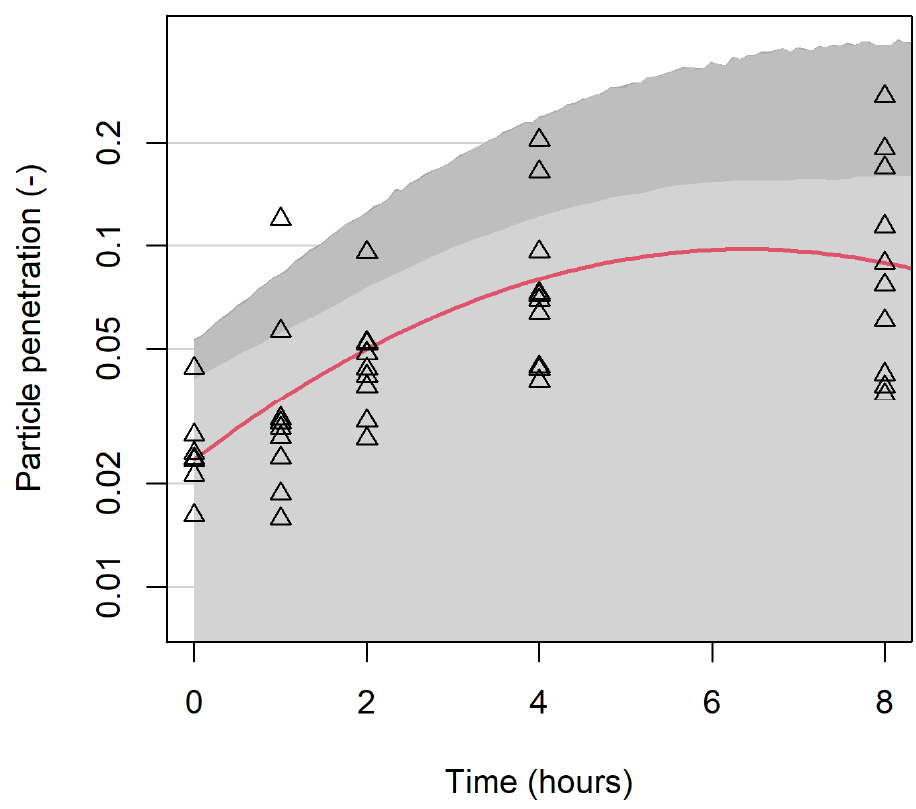
Figure 9. Penetration (P 0.3 ) of samples after wearing for 0–8 h. Experimental results are shown by triangles; the red curve shows modelled mean penetration. Light shading gives 95% confidence intervals for mean penetration, and dark shading for observations on individual masks.